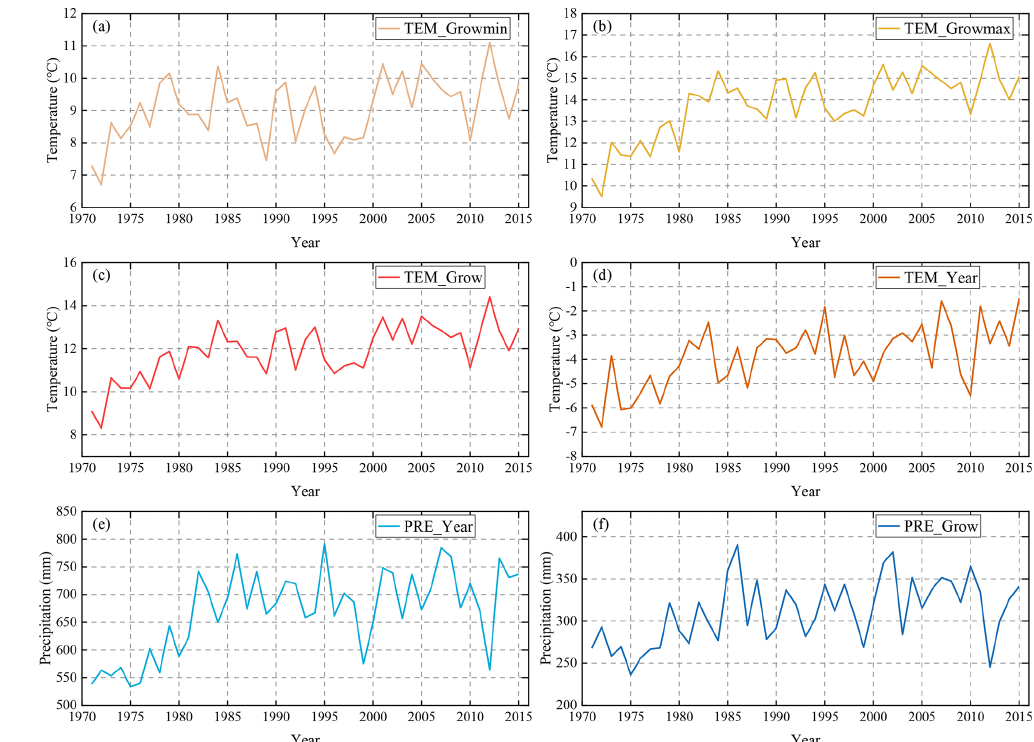
Figure 11. Statistics of temperature and precipitation in study area from 1971 to 2015: (a) average minimum temperature during the growing season, (b) average maximum temperature during the growing season, (c) average temperature during the growing season, (d) average annual temperature, (e) total annual precipitation and (f) total precipitation during the growing